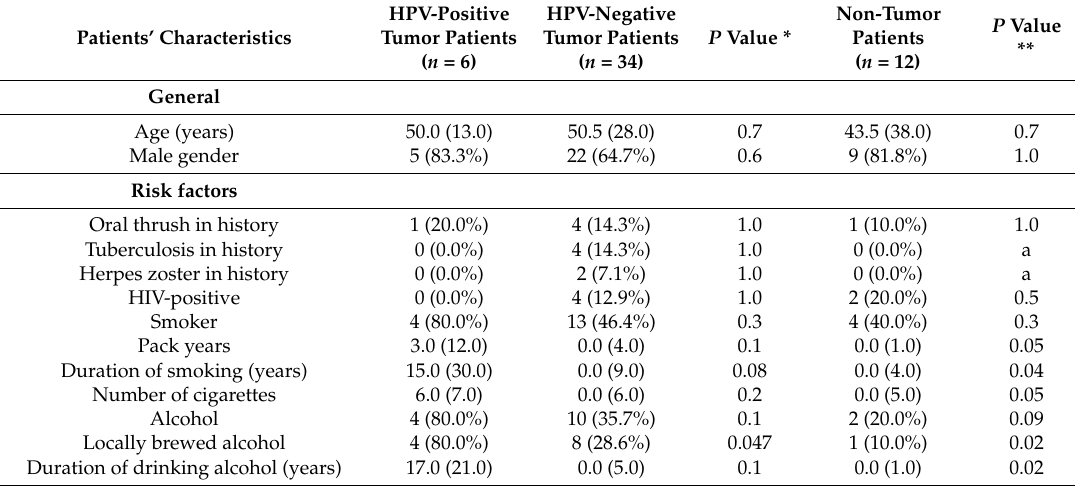
Table 2. Clinico-pathological characteristics of